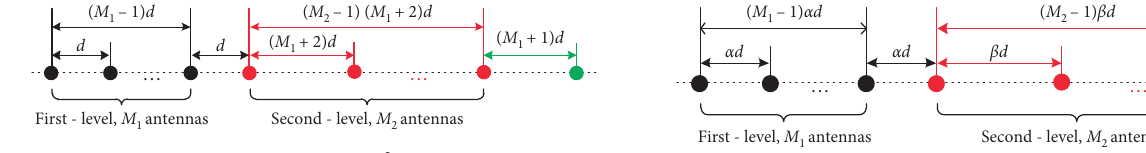
Figure 2: GNA configuration.